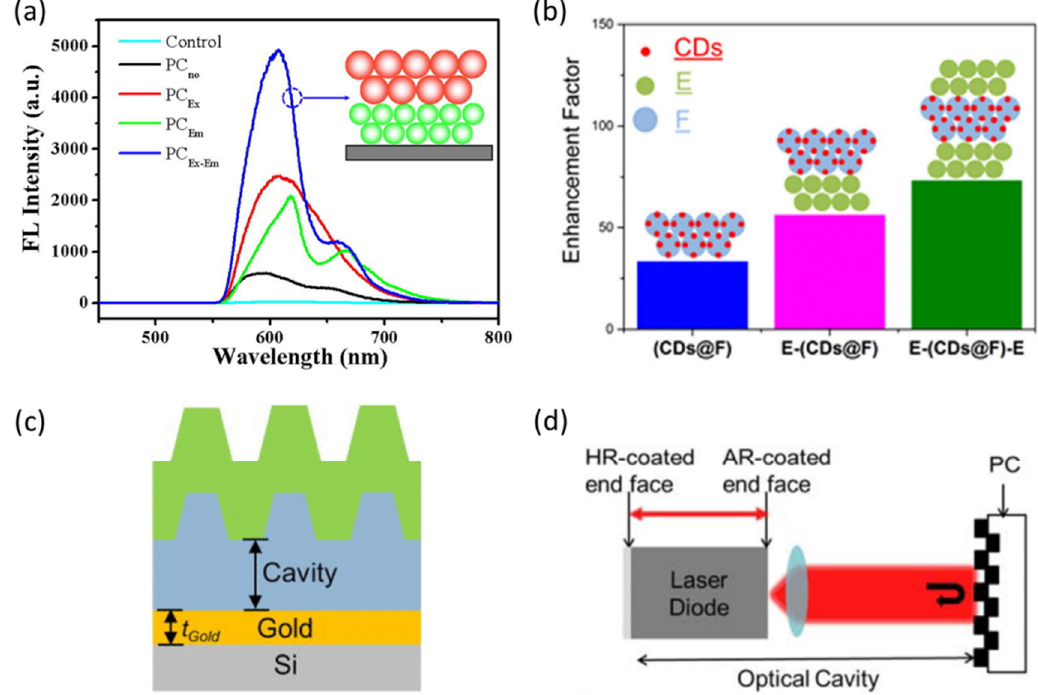
Figure 6. ( a ) Fluorescence spectra of Nile Red absorbed on the control sample and PCs with colloidal particle diameters of 180 nm (PCno), 210 nm (PCEx), 260 nm (PCEm), and 210down–260up nm (PCEx–Em). The inset shows the heterostructure PC films made of different self-assembly concentrations of P(St–MMA–AA) spheres, adapted with permission from [162]. ( b ) Fluorescence enhancement factor for all samples, measured as the fluorescence intensity ratio between the sample and the control, adapted with permission from [163]. ( c ) Cross-sectional schematic (not to scale) of the cavity-coupled PC, adapted with permission from [35]. ( d ) The resonantly reflected laser wavelength from the PC provides feedback to the diode. The cavity then lases at the resonant wavelength of the PC, adapted with permission from [79].